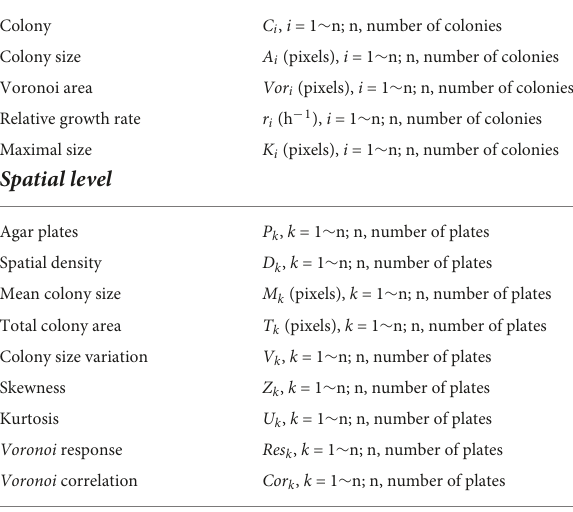
TABLE 1 The parameters